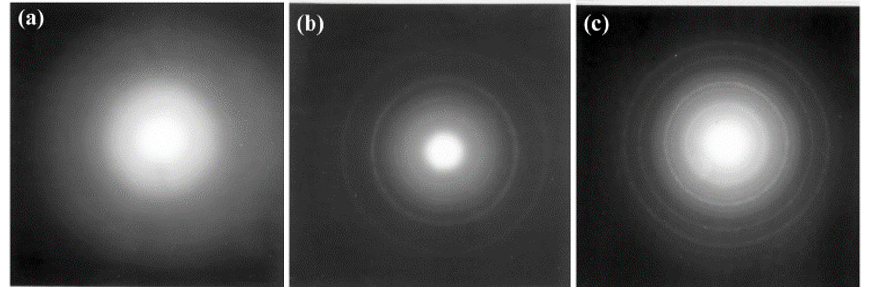
Figure 11. SAED patterns of amorphous MgO at fluences of ( a ) 0, i.e., before irradiation, ( b ) 3 × 10 17 electrons/cm 2 , showing rings indicating crystallization, and ( c ) 5 × 10 18 electrons/cm 2 , where MgO rings disappeared and new forsterite rings appeared. Reproduced from ref. [57].